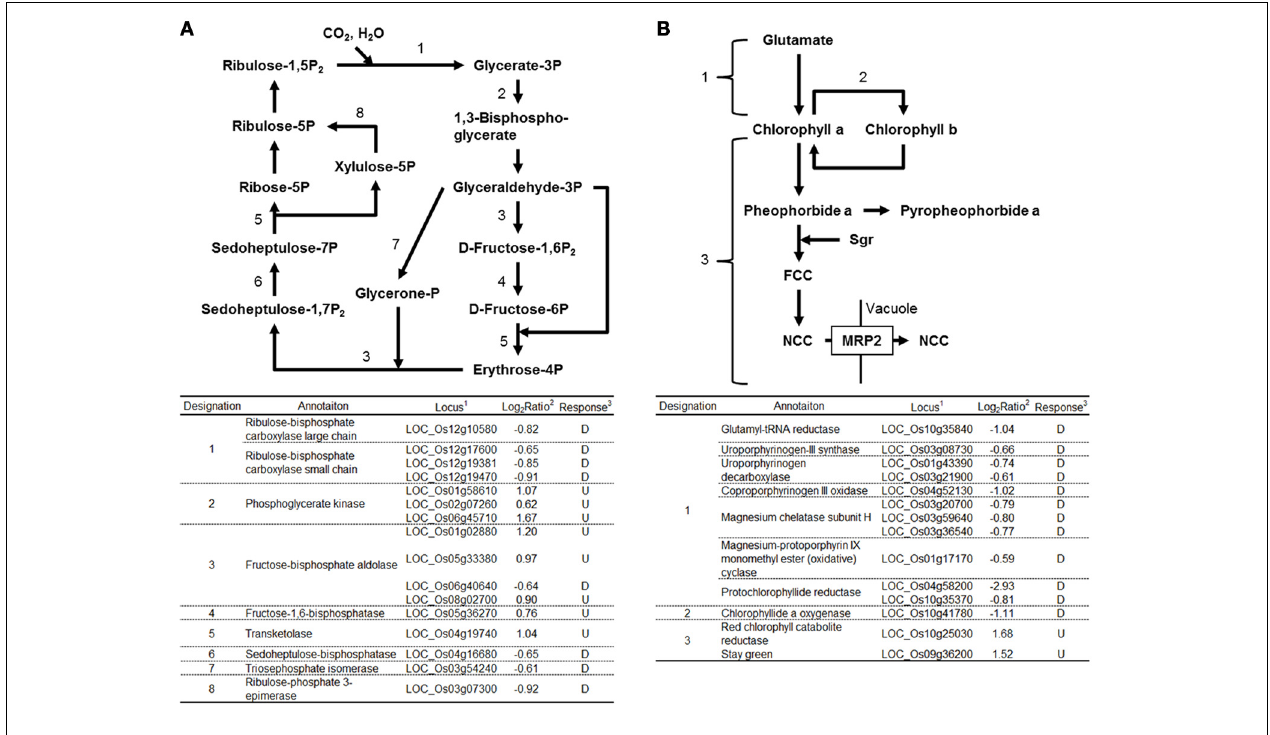
FIGURE 2 | Genes related to Calvin-Benson cycle and chlorophyll metabolisms in RGSV-infected plants that are up- or down-regulated. Responses of genes for (A) Calvin-Benson cycle, and (B) chlorophyll metabolism. Enzymes catalyzing reactions are shown in the table